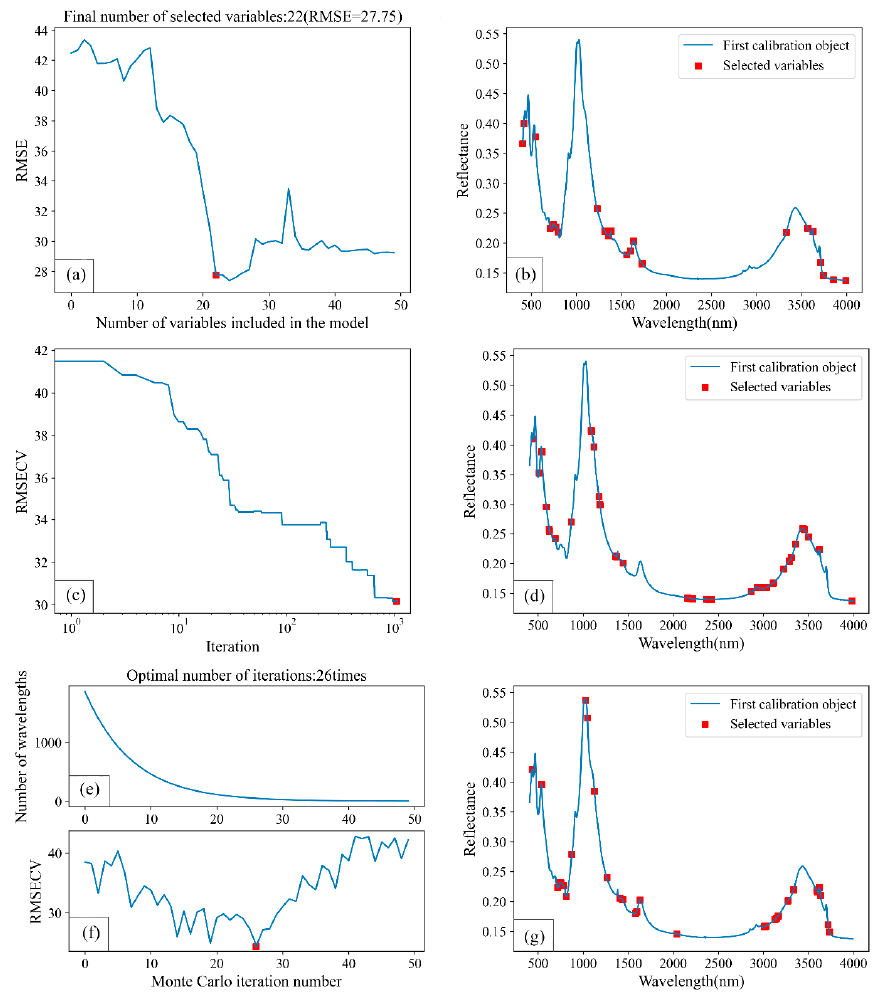
Figure 4. Variables selection process using different dimensionality reduction algorithms. ( a ) Final number of variables selected by the SPA, ( b ) the spectral bands selected by SPA, ( c ) RMSECV change for different iterations using SA algorithm, ( d ) the spectral bands selected using SA, ( e ) the optimal number of iterations using CARS, ( f ) the RMSECV change for different numbers of Monte Carlo iterations in CARS algorithm, and ( g ) the spectral wavelengths selected using CARS algorithm. Note: RMSE, root mean square error. RMSECV, interactive veri fi cation of root mean square error.